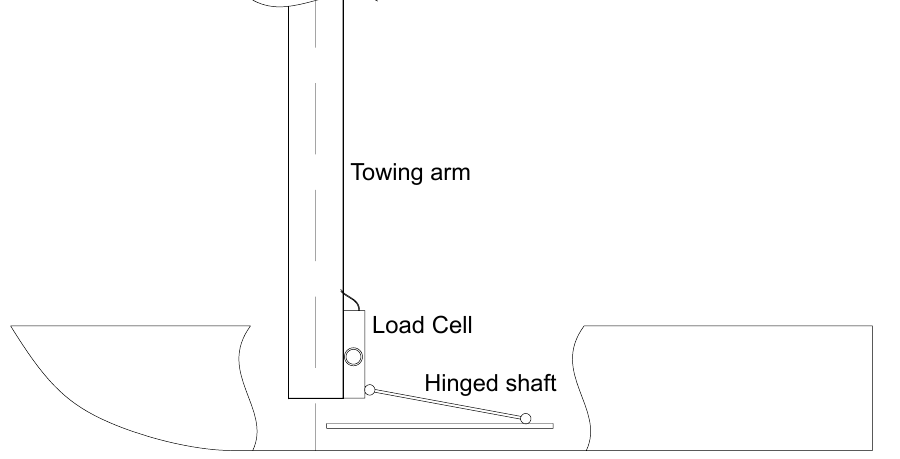
Figure 3. Experimental